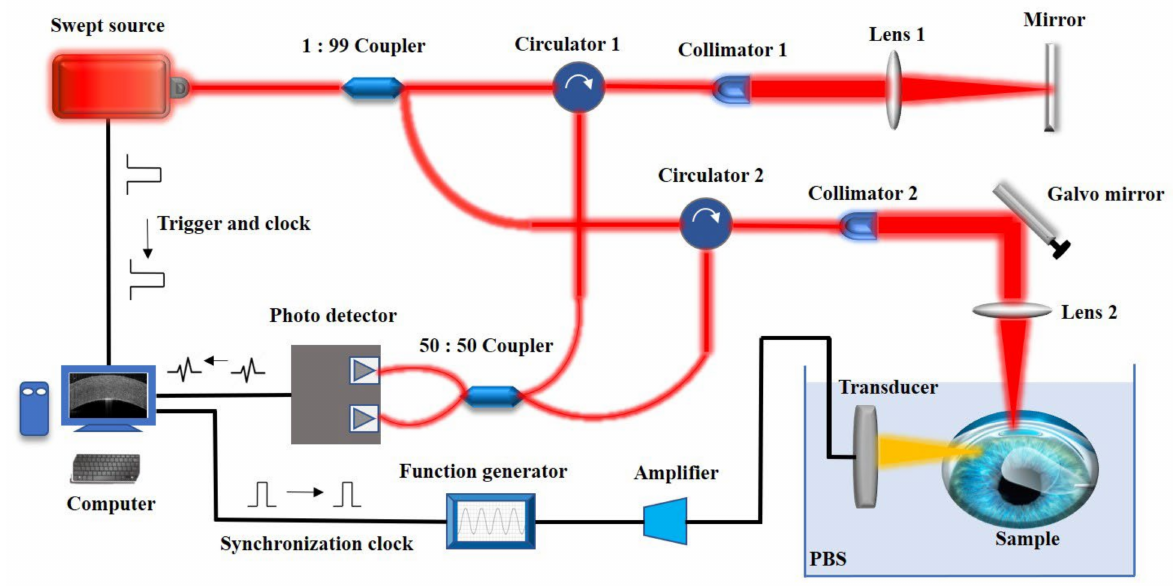
Figure 2. The acoustic radiation force based OCE system diagram. The swept laser with a central wavelength of 1310 nm is split by a 1:99 optical coupler and then enters the reference arm and the sample arm, respectively, and the interference signal is detected by an optical balance detector. The laser provides the sampling trigger signal and sampling clock signal. The synchronization control signal of the acoustic radiation force excitation is generated by the computer and synchronized with the OCT sampling